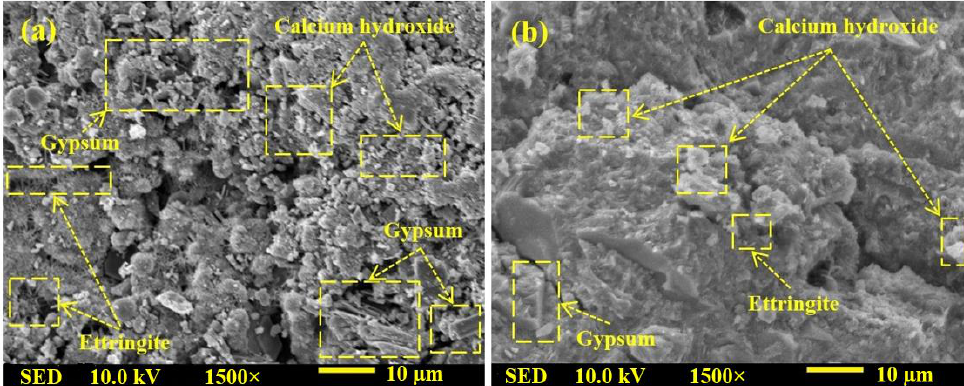
Figure 8. SEM images of GPMs exposed to 10% of H 2 SO 4 for 365 days containing ( a ) 50% and ( b ) 70% of WCT.